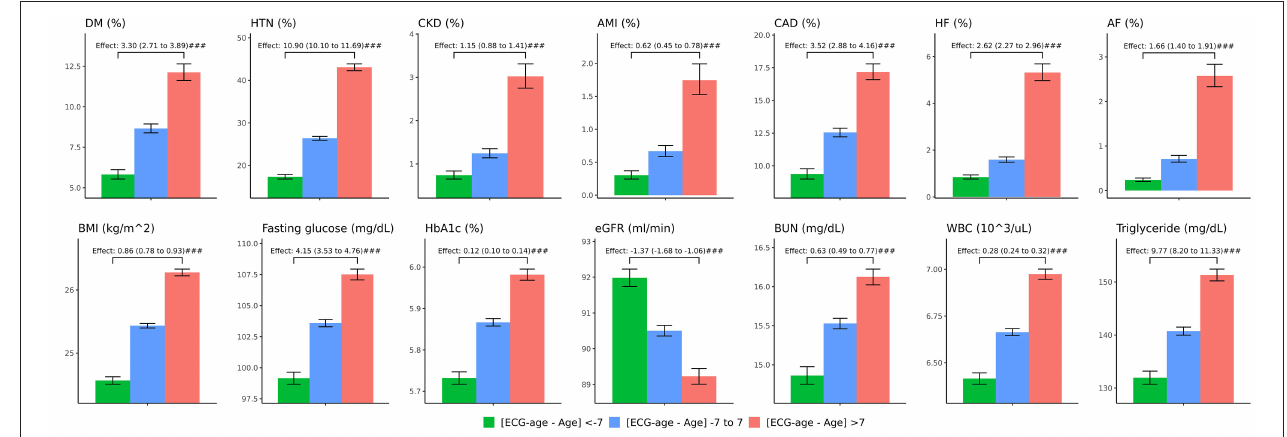
FIGURE 4 | The comparison between higher ECG-age and lower ECG-age for outcomes of interest in validation set. The plots display three groups, with ECG-age more than 7 years greater than the chronological age (denoted by: ECG-age –Age > 7, red columnar) those with ECG-age within a range of 7 years from their chronological age (denoted by: ECG-age –Age-7 to 7, blue columnar); and, those with ECG-age more than 7 years smaller than the chronological age (denoted by: ECG-age –Age < 7, green columnar). X-axis is cumulative incidence and y axis is year. We can find red columnar is obvious with high hazard ratio on all outcomes of interest with statistics significant. Green columnar demonstrated opposite effect on all outcomes of interest.